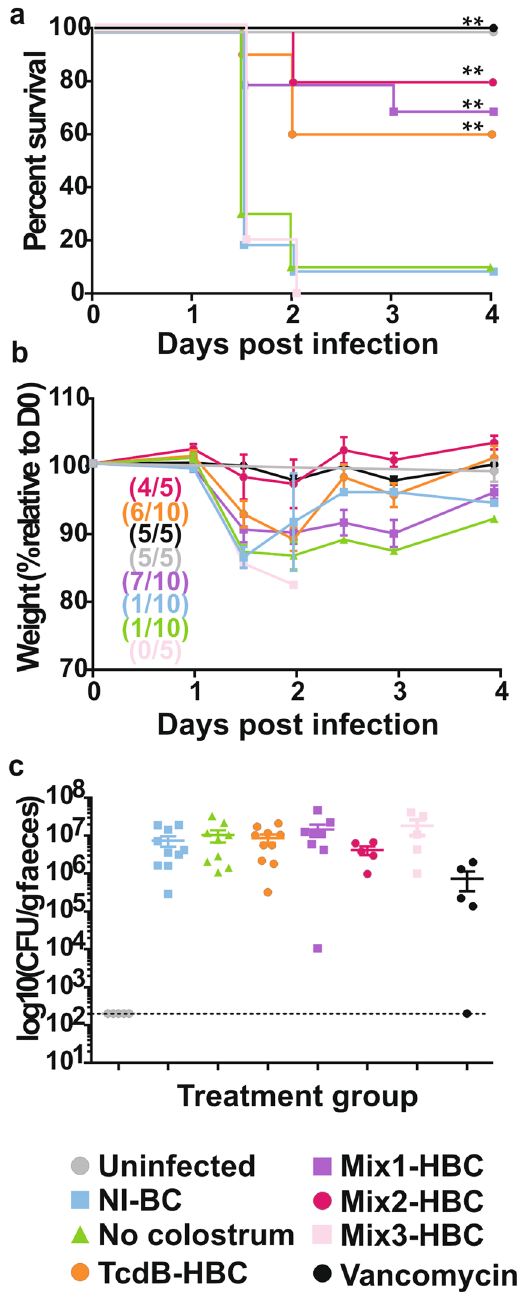
Figure 5. Prevention of primary CDI by HBC mixtures. Mice were untreated (no colostrum) or were pre- treated with NI-BC, TcdB-HBC, Mix1-HBC, Mix2-HBC, Mix3-HBC or vancomycin prior to infection. Uninfected, untreated mice were controls. Mice were monitored daily for survival ( a ) and weight loss ( b ). Weight loss is presented as the % weight relative to the day of infection (day 0 or D0). Numbers in brackets indicate the number of surviving mice at the completion of the experiment compared to (/) the total number of mice at the beginning of the experiment. Faecal spore load is presented as CFU/gram faeces (log 10 ), with each point representing a single mouse. The limit of detection is represented as a dotted line ( c ). Error bars represent the mean ± SEM of n = 5–10